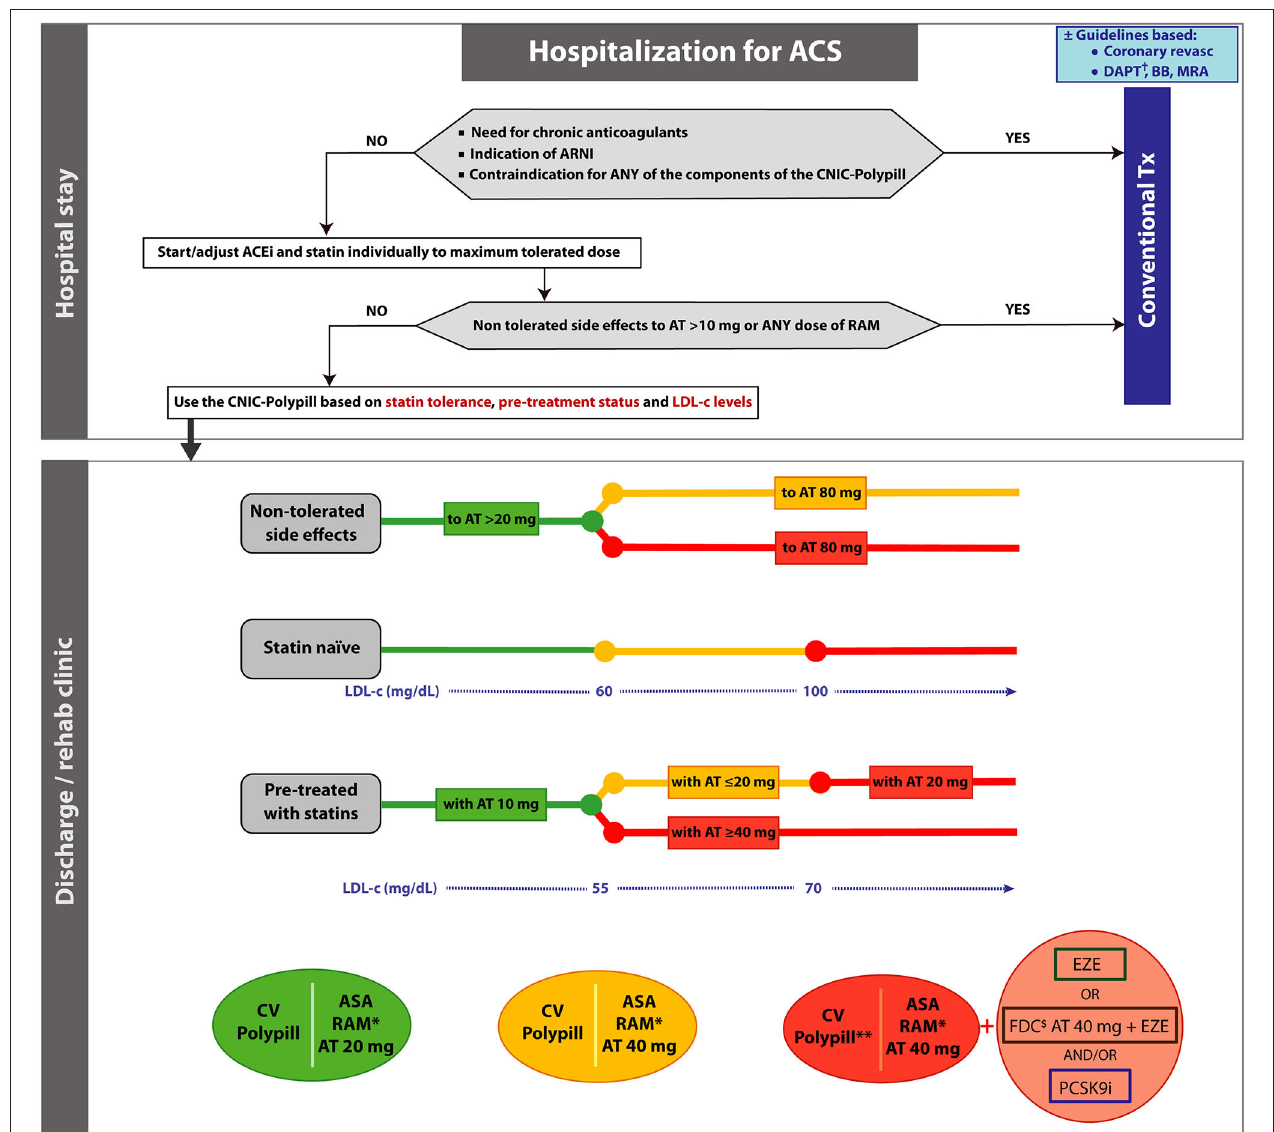
FIGURE 1 | Algorithm showing the steps and options to switch patients hospitalized for an acute coronary syndrome to the CNIC-Polypill strategy. Note: The colored balls represent the appropriate formulation of the CNIC-Polypill according to the colored lines of the algorithm. † Select P2Y 12 inhibitor in addition to the CNIC-Polypill. *Dose adjusted to BP levels, previous ACEI/ARB dose and renal function. **Reassess in 3–4 weeks after discharge and readjust the dosage, consider adding A40 or ezetimibe and/or a PCSK9i. $ Use only if the patient does not develop side effects to atorvastatin 80mg (or equivalent doses of another statin). ACEI, angiotensin-converting enzyme inhibitor; ACS, acute coronary syndrome; ARB, angiotensin II receptor blocker; ARNI, angiotensin receptor neprilysin inhibitor; ASA, acetylsalicylic acid; AT, atorvastatin; BB, beta blocker; BP, blood pressure; DAPT, dual platelet therapy; EZE, ezetimibe; FDC, fixed-dose combination; LDL-c, low-density lipoprotein cholesterol; PCSK9i, proprotein convertase subtilisin/kexin type 9 inhibitor; RAM, ramipril; Tx,